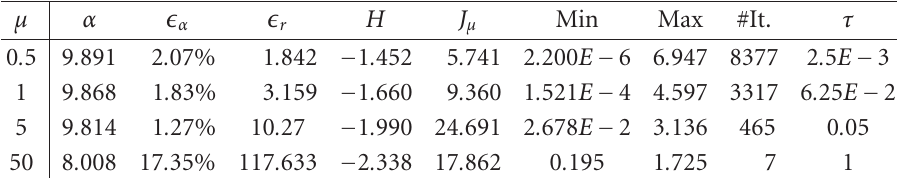
Table 6.1. Results obtained for a simulated noisy data V of a sum of three Dirac measures. We have made four computations for di ff erent values of the regularization parameter µ . The Min and Max are, respectively, the minimum and the maximum of the solution on E